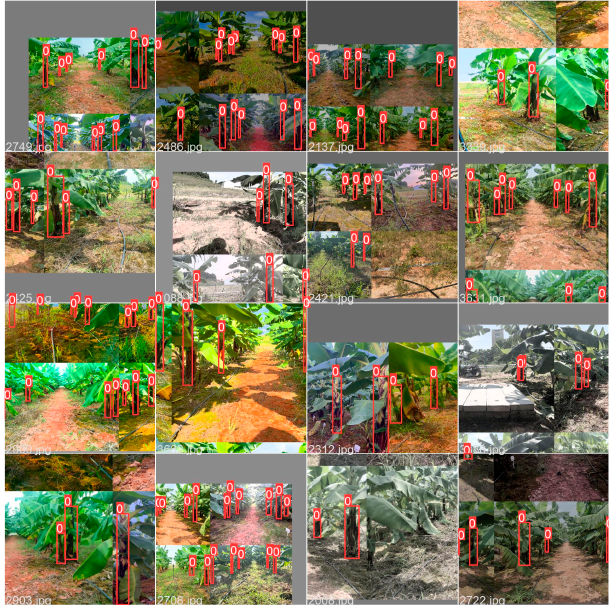
Figure 3. Sample generation by means of image augmentation. The red boxes represent trunks and the numbers above the red boxes represent the category numbers.